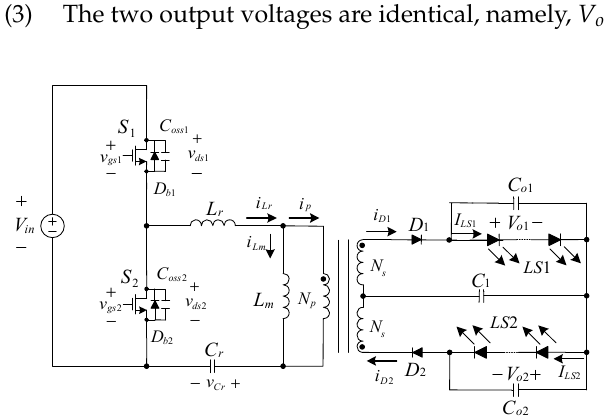
Figure 2. Proposed two-channel LLC resonant LED driver.